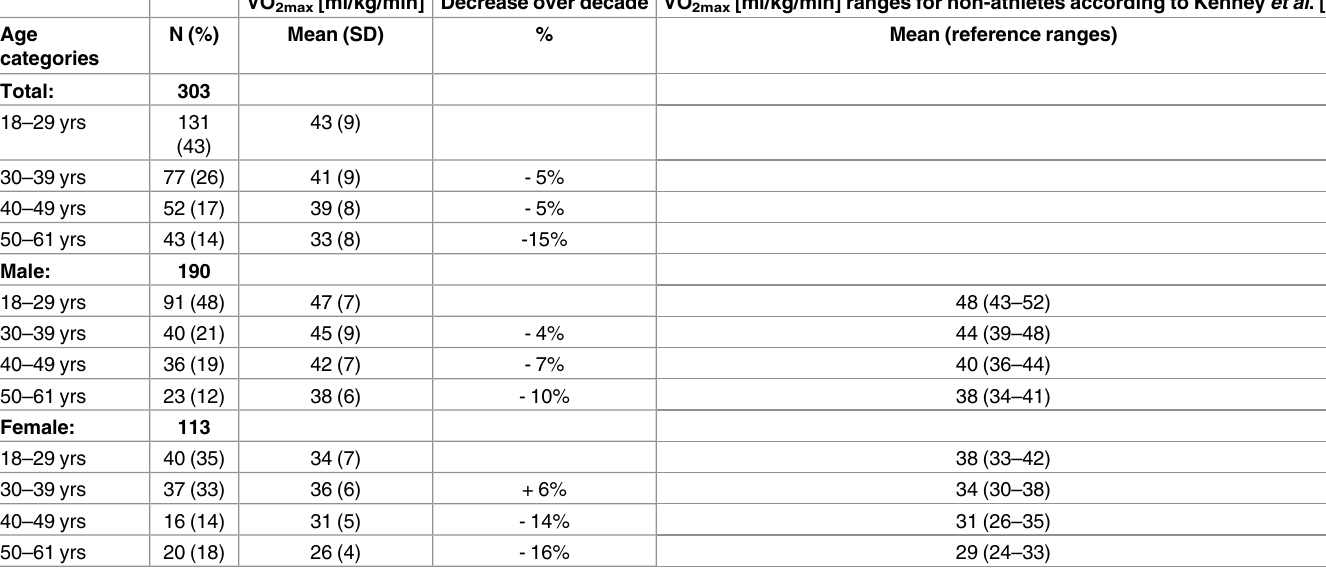
Table 4. VO 2max referencevalues according to age and